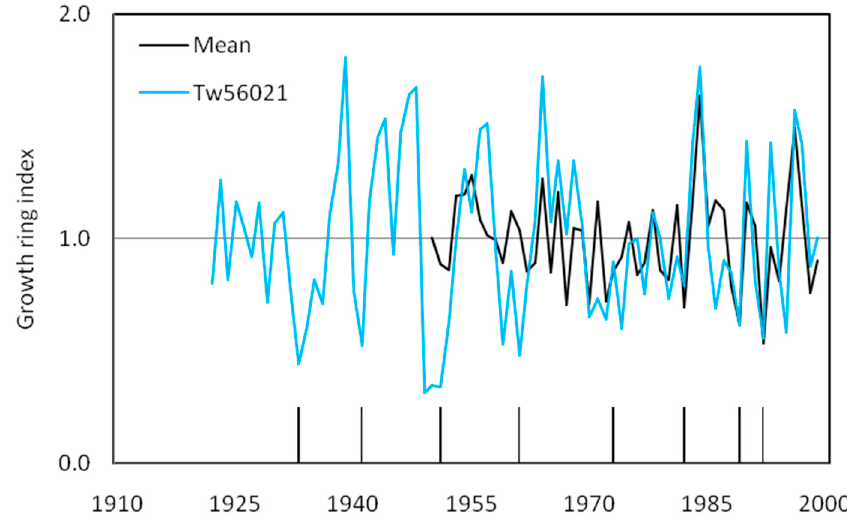
Figure 5. Growth ring index of the fire trace sample of D. butyracea (Tw56021) and mean chronology; vertical bars are fire